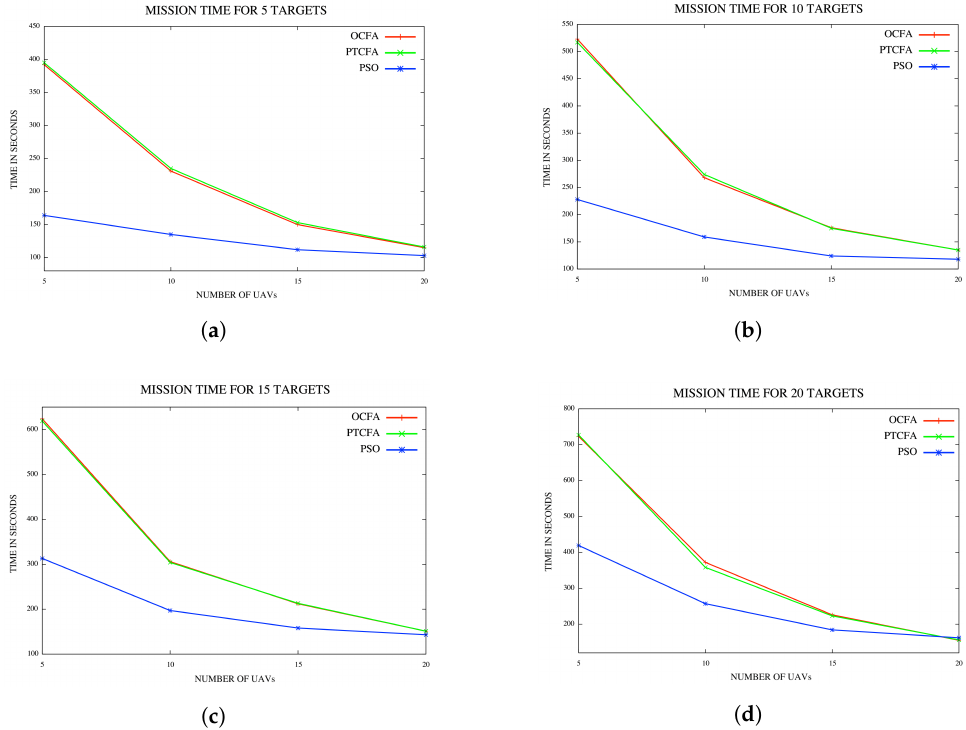
Figure 13. ( a ) Mission time for five targets/locations; ( b ) mission time for 10 targets/locations; ( c ) mission time for 15 targets/locations; ( d ) mission time for 20